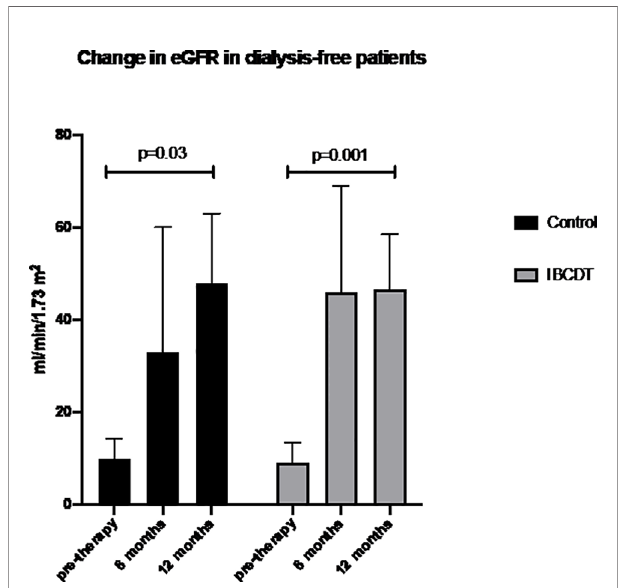
FIGURE 2 | SequentialeGFRfortheIBCDTanddailyoralcyclophosphamidegroups inpadialysis-freepatients.Dataarepresentedasmean±SD.eGFR=estimated